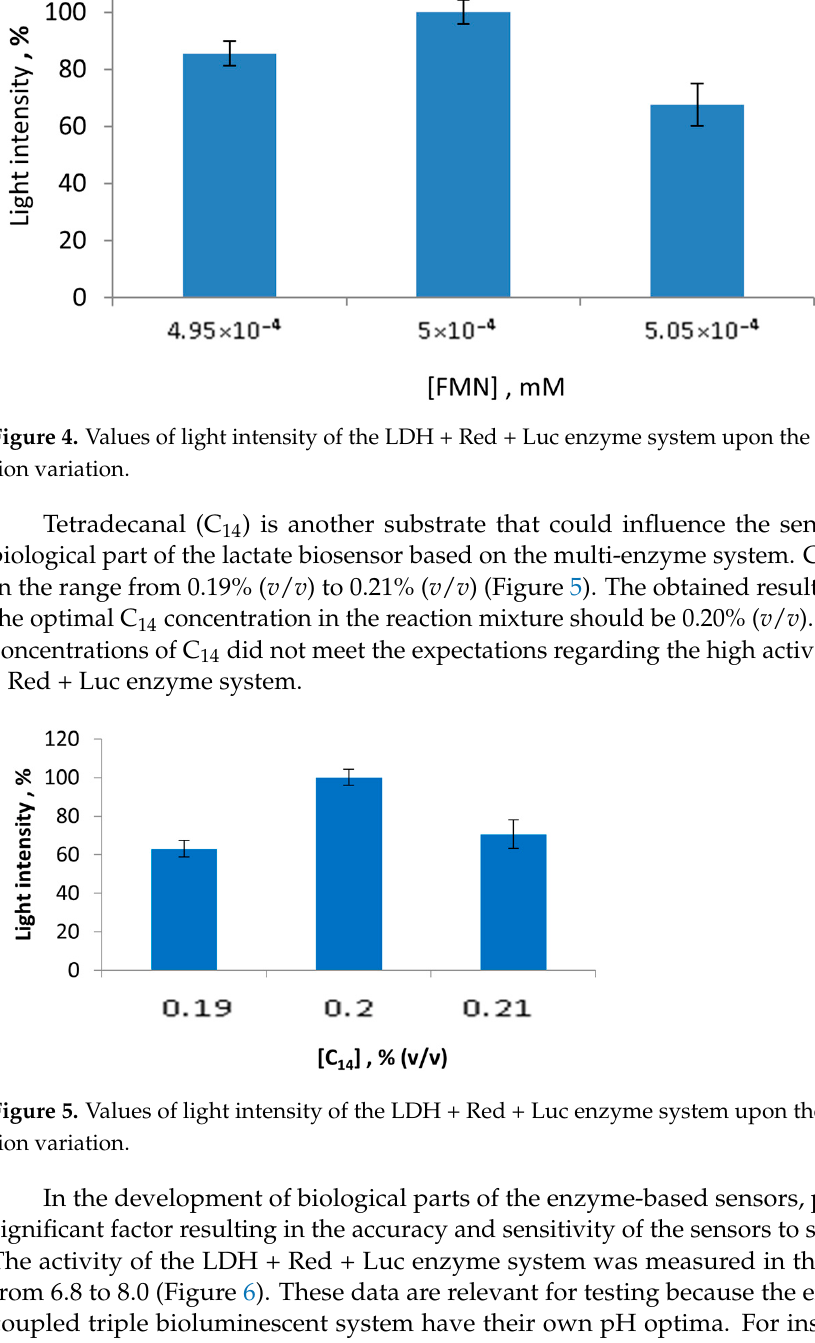
Figure 3. Values of light intensity of the LDH + Red + Luc enzyme system upon the NAD + concentration variation.